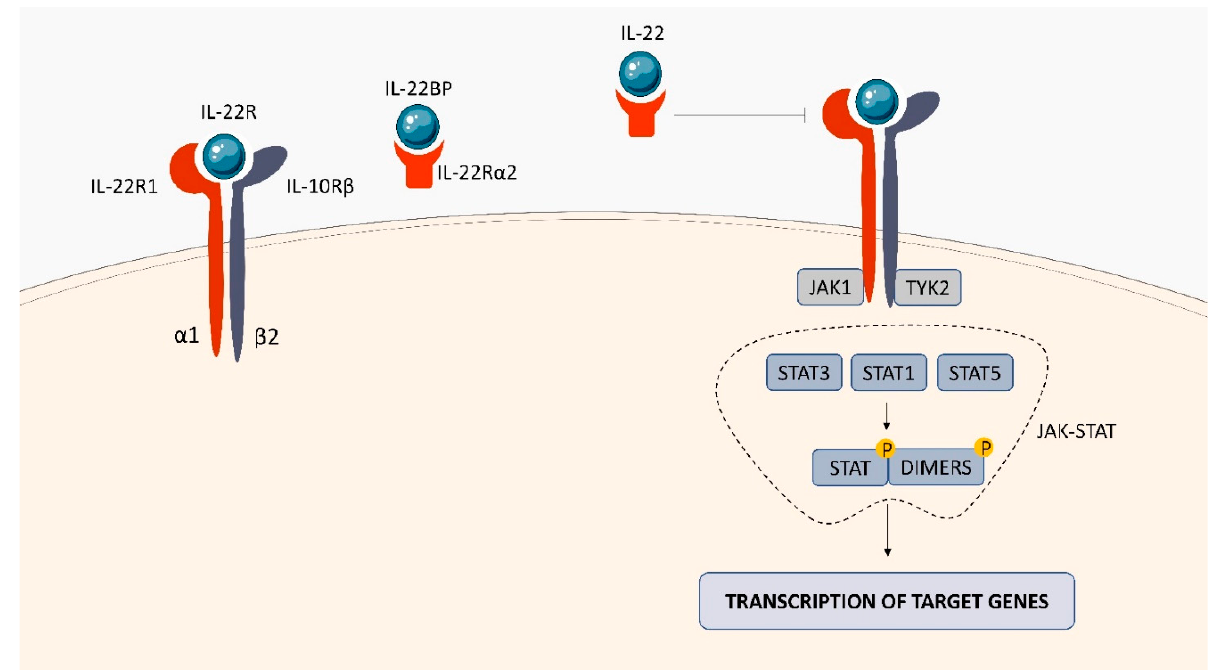
Figure 9. IL-22R structure and signaling. IL-22R consists of 2 subunits (IL-22 α 1 and IL-10b2). Interaction of IL-22 with IL-22R activates JAK1/TYK2 tyrosine kinases. The JAK-STAT pathway is then activated, which stimulates the transcription of genes in the cell nucleus, leading to the production of cytokines